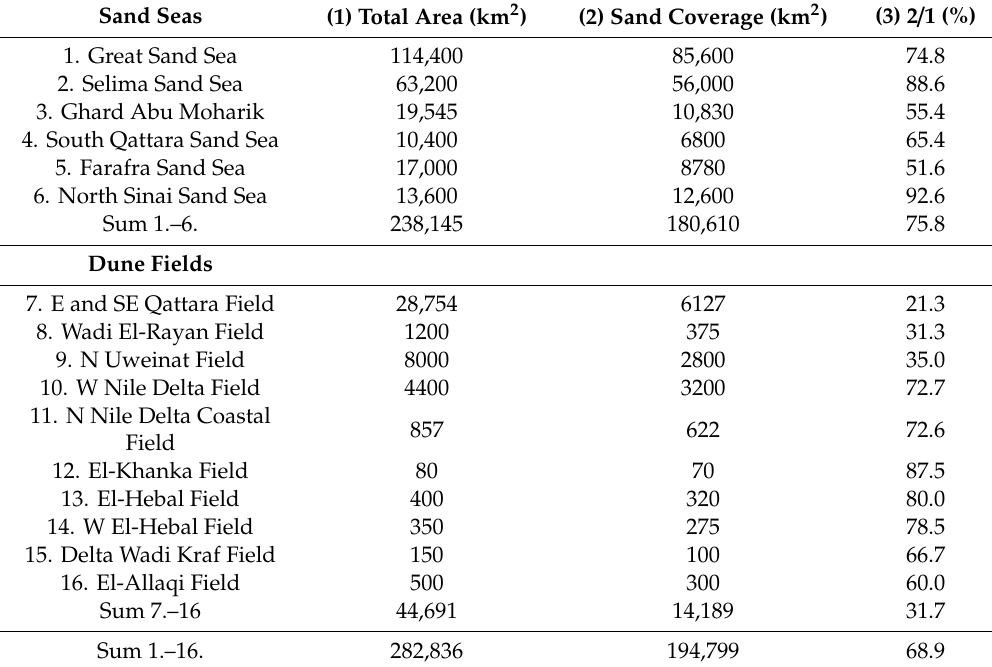
Table 1. Names and areas of sand seas and dune fields in